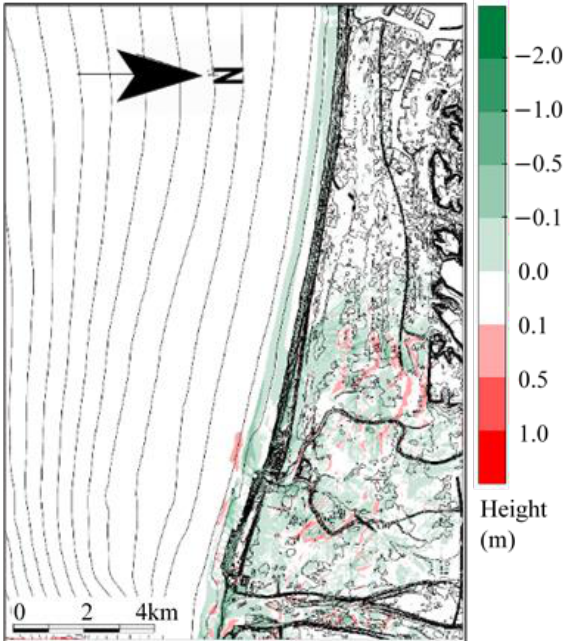
Figure 20. Topography change due to suspension load only, 33 min after the start of calculation (present condition).